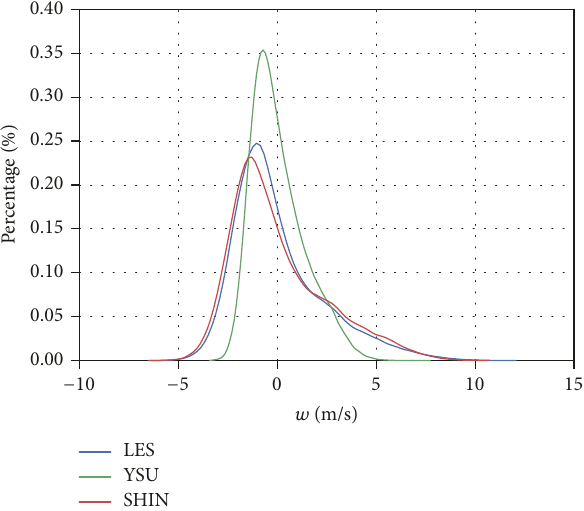
Figure 12: Probability distribution of vertical velocity from model